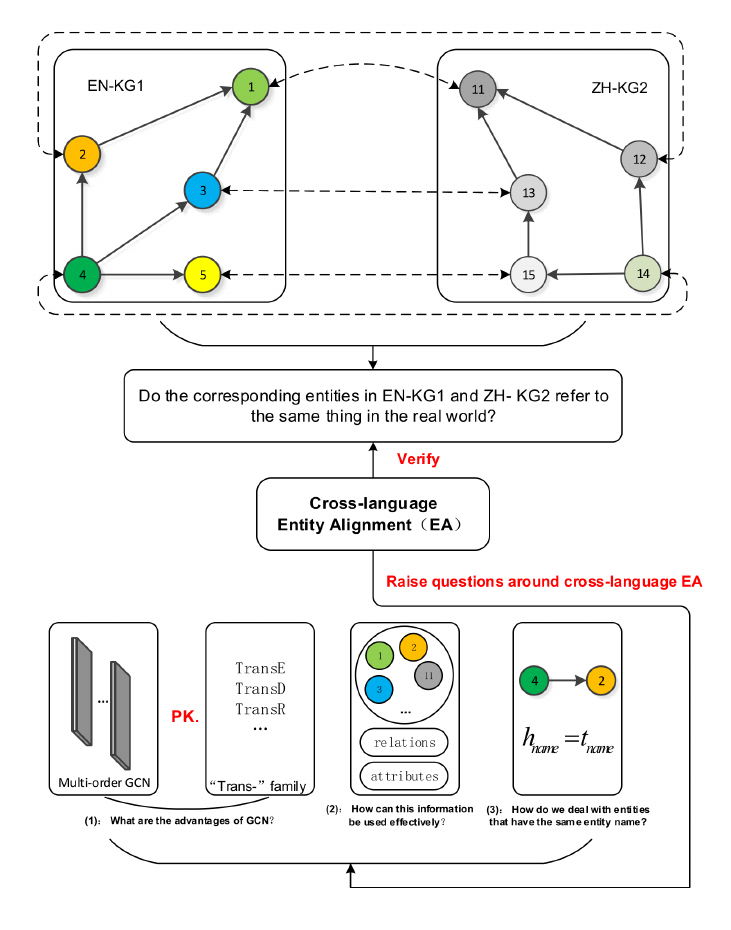
Figure 3. Problem